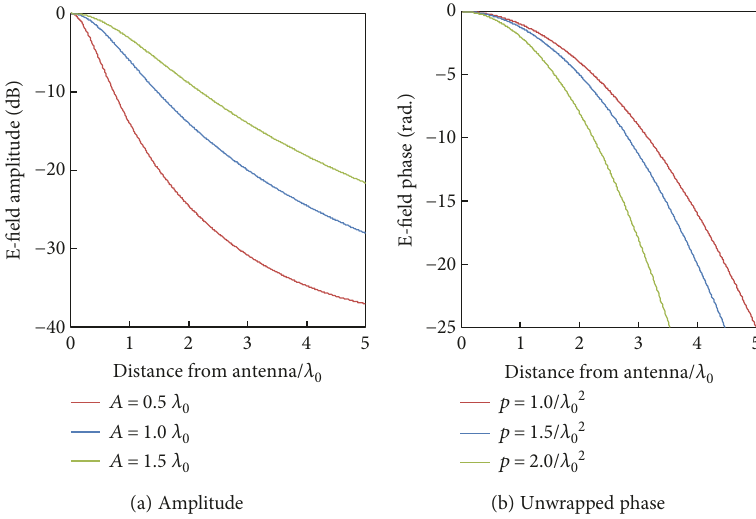
Figure 6: Approximated normalized electric fi eld intensity distribution.